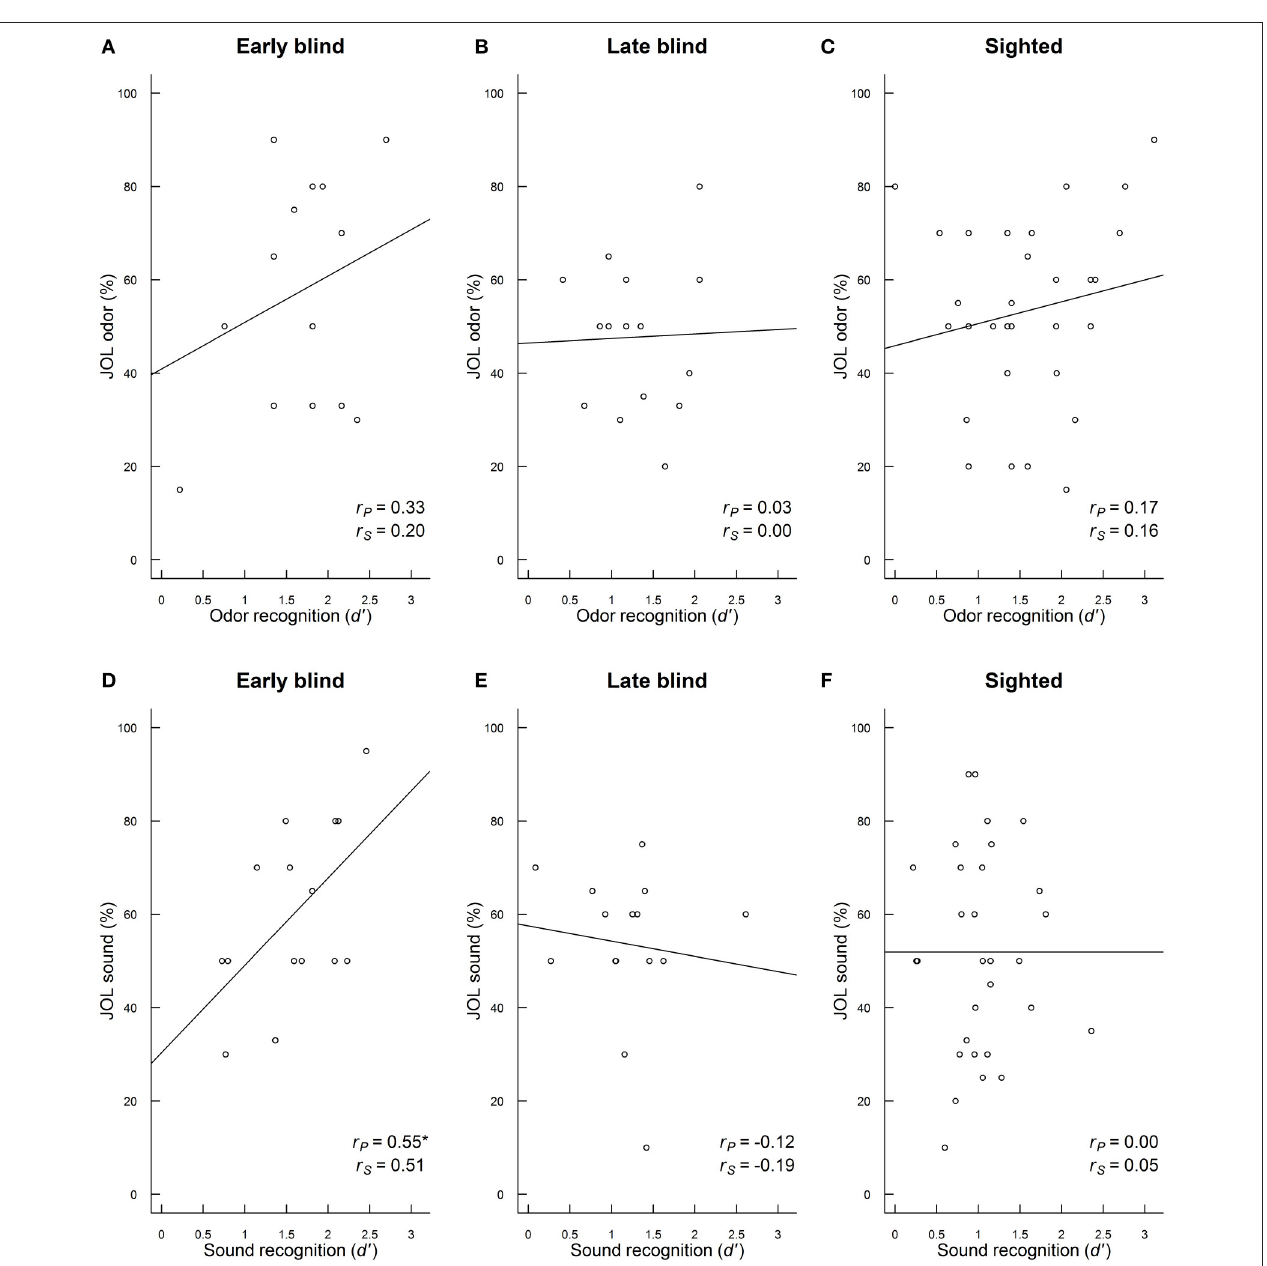
FIGURE 2 | (A–F) Correlations of judgments of learning (JOLs) with episodic recognition (d’) for odors (A–C) and sounds (D–F) in early blind, late blind, and sighted participants. The Pearson product-moment correlation coefficient (rP) with fitted regression line (ordinary least squares), and the Spearman’s rank correlation coefficient (rS) are depicted. * p <